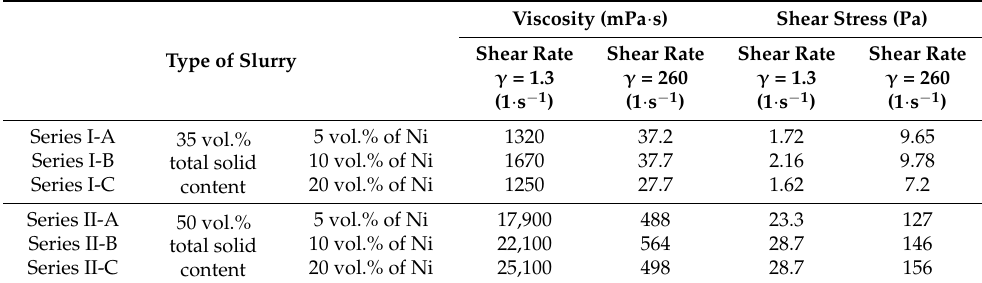
Figure 5. Viscosity curves and flow curves of the ZrO 2 -Ni composite slurry. Table 3. Minimum and maximum values of viscosity and shear stress for the slurries tested.